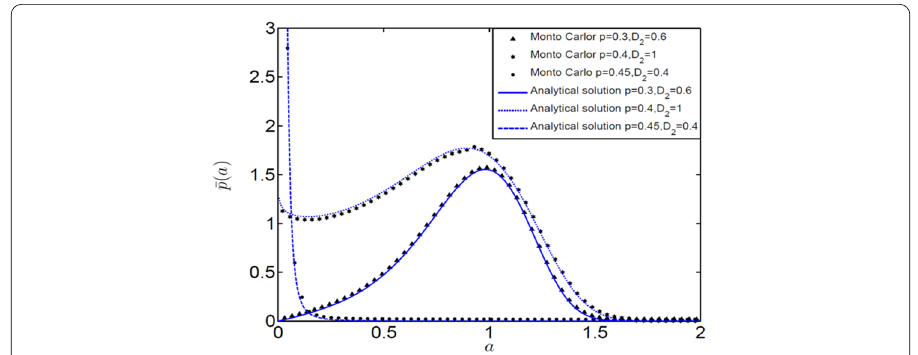
Figure 12 PDFs for ¯ p ( a ) under multiplicative noise excitation (taking p and D 2 as unfolding parameters)